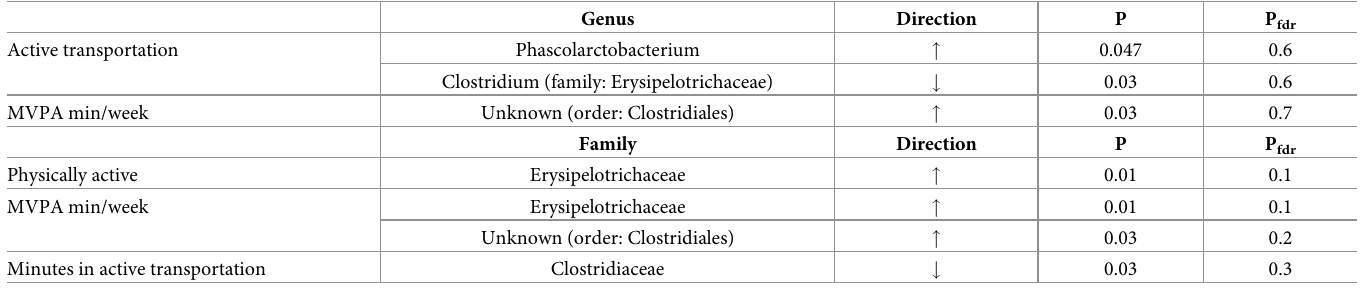
Table 4. Results of negative binomial models, before and after adjustment for multiple